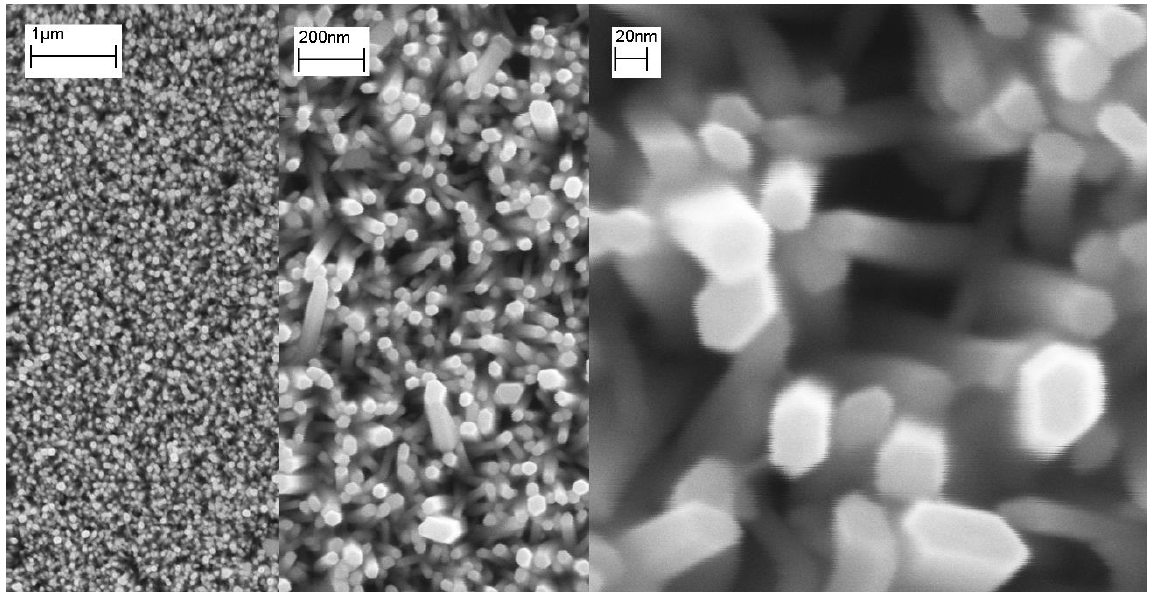
Figure 1 6 . SEM images of the ZnO nanorods grown on Ag-coated n-Si substrate using low temperature growth (different magnification of the same